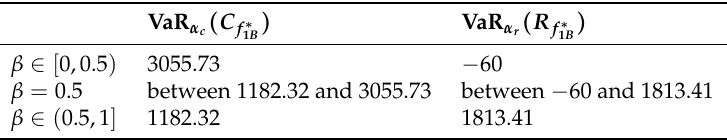
Table 2. VaRs of the cedent and the reinsurer when f ∈ C 1